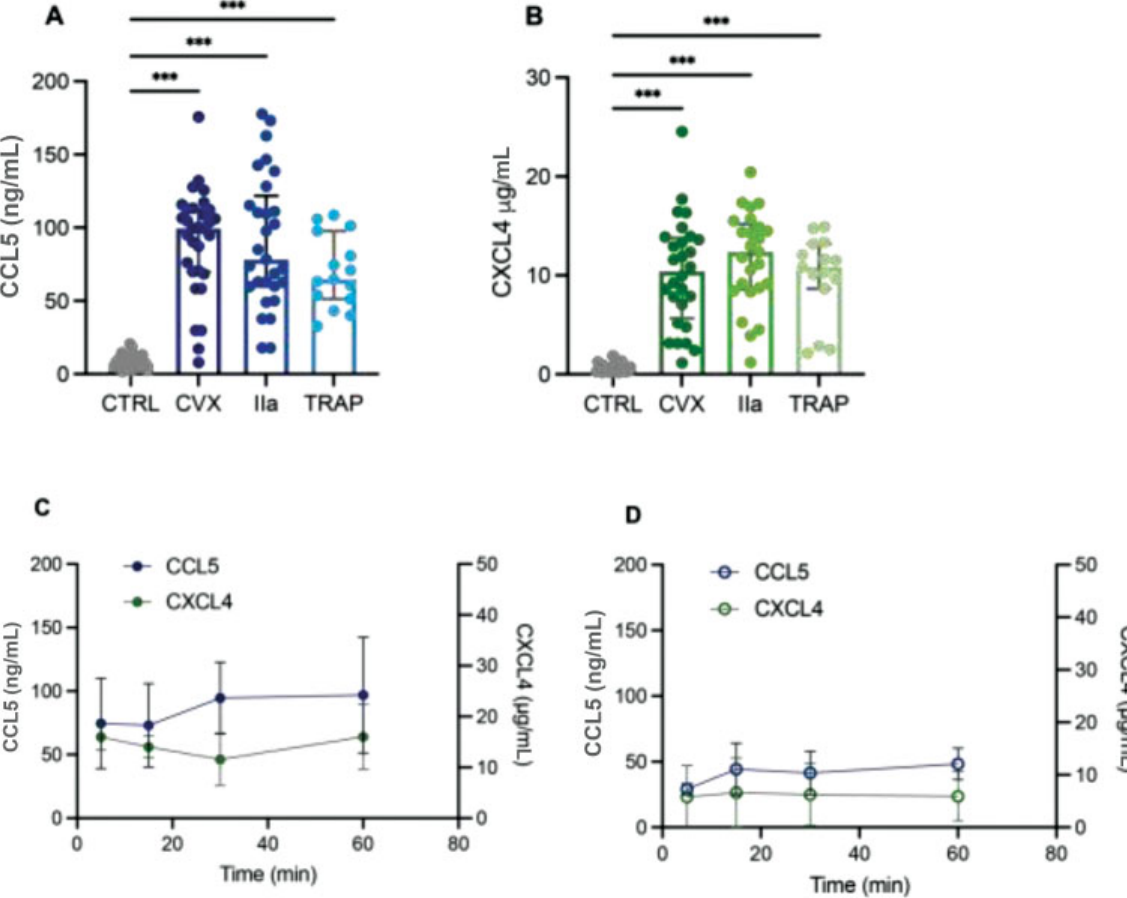
Fig. 1 Different platelet activation pathways have no in fl uence on chemokine release. Washed platelets (2 (cid:1) 10 8 /mL) were activated with convulxin (CVX, 100 ng/mL), thrombin (IIa, 5nM), or TRAP-6 (50 µM) for 30minutes at 37°C. Platelets were removed and chemokines CCL5 ( A ) and CXCL4 ( B ) were determined with enzyme-linked immune sorbent assay. Control (CTRL) represents no stimulated platelets. Chemokine release was followed in time after convulxin ( C ) and thrombin ( D ) activation. Closed circles represent convulxin activation and open circles represent thrombin activation. CTRL: n ¼ 31; CVX: n ¼ 28 – 30, IIa: n ¼ 25 – 29; and TRAP-6: n ¼ 15. Median with interquartile range ( A, B ); mean (cid:3) standard deviation ( C, D ). (cid:4)(cid:4)(cid:4) p < 0.001, Kruskal – Wallis with Dunn ’ s